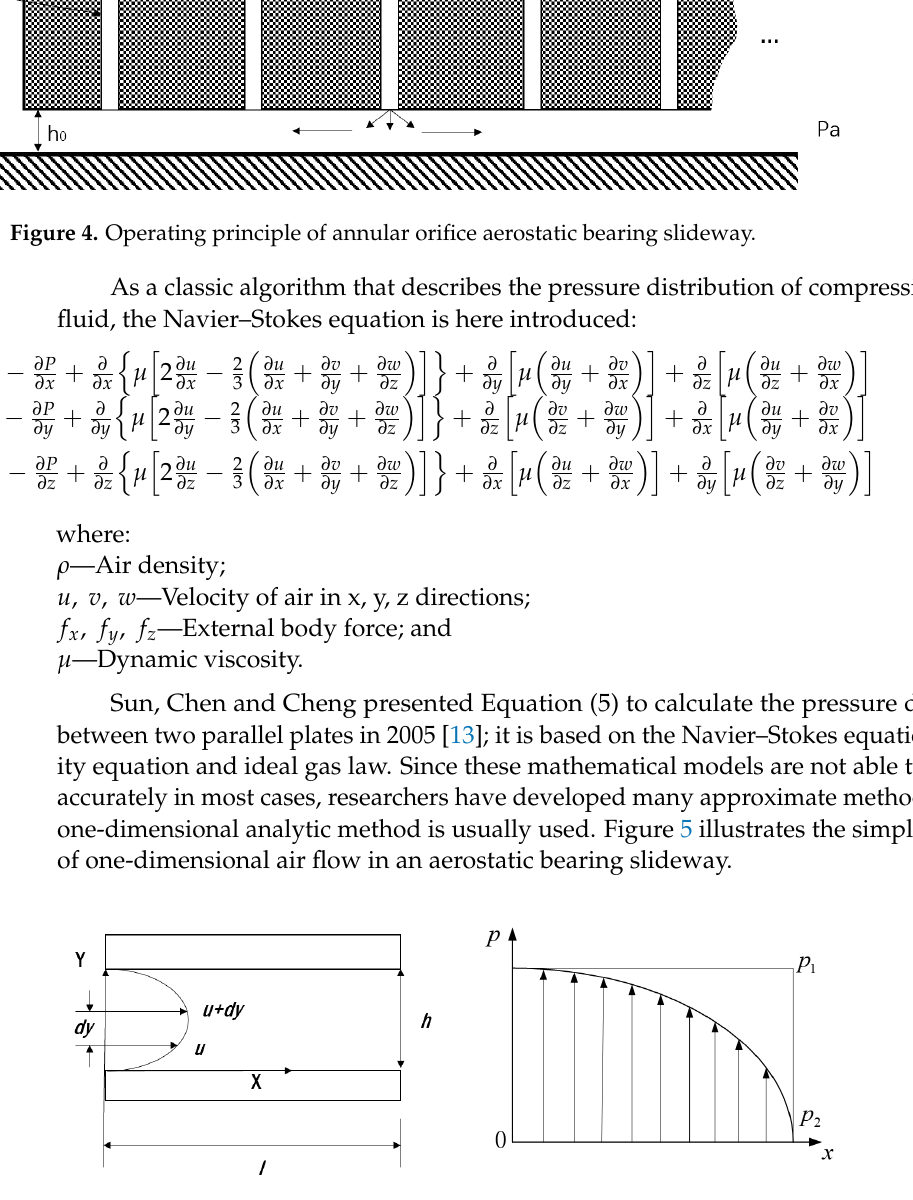
Figure 5. One-dimensional model of the parallel plates.